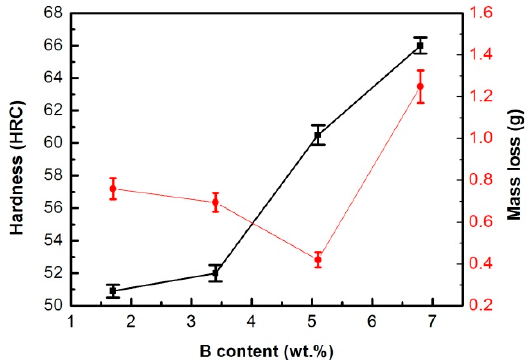
Figure 7. Rockwell hardness and mass loss (during wear testing) plotted as a function of the B contents of the hardfacing layers.